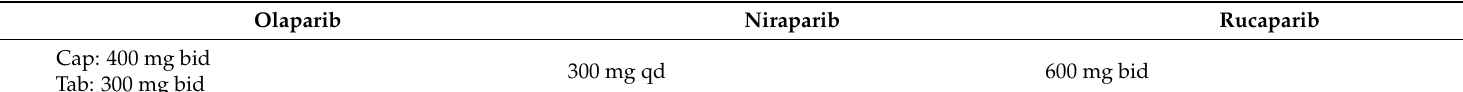
Table 3. Toxicity data from SOLO2, NOVA, ARIEL3 and FDA, EMA reports [143–147]. Cap: capsule, Tab: Tablet, GI: Gatrointestinal, ALT: Alanine aminotransferase, AST: aspartase aminotransferase, BID: twice daily, QD: once daily, Ch: